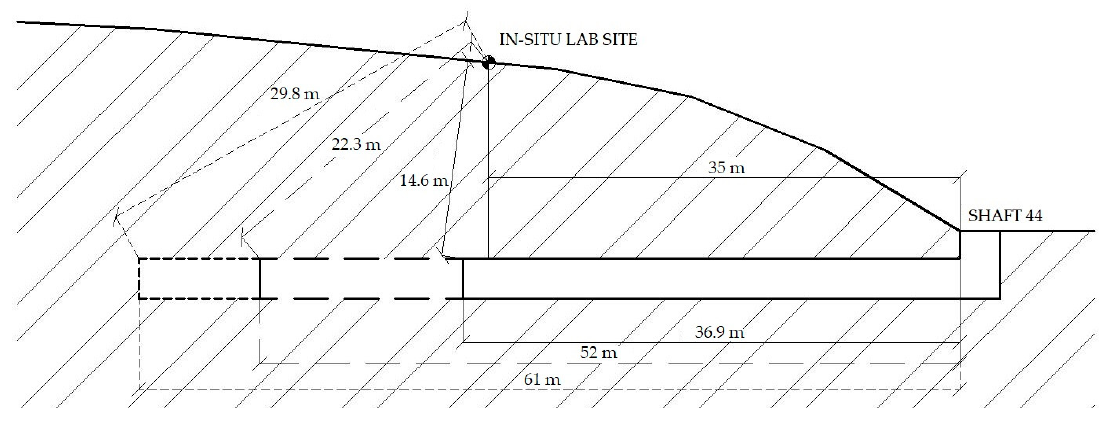
Figure 11. A measurement situation.